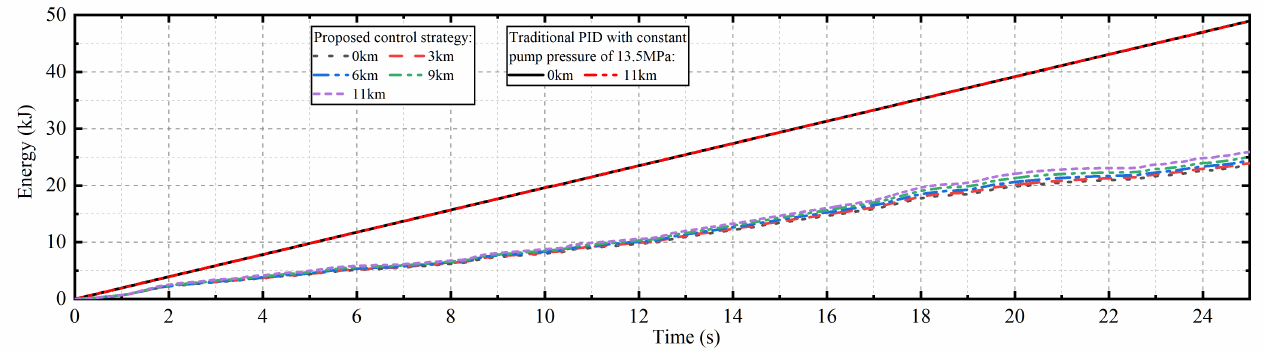
Figure 18. Energy consumption of complex